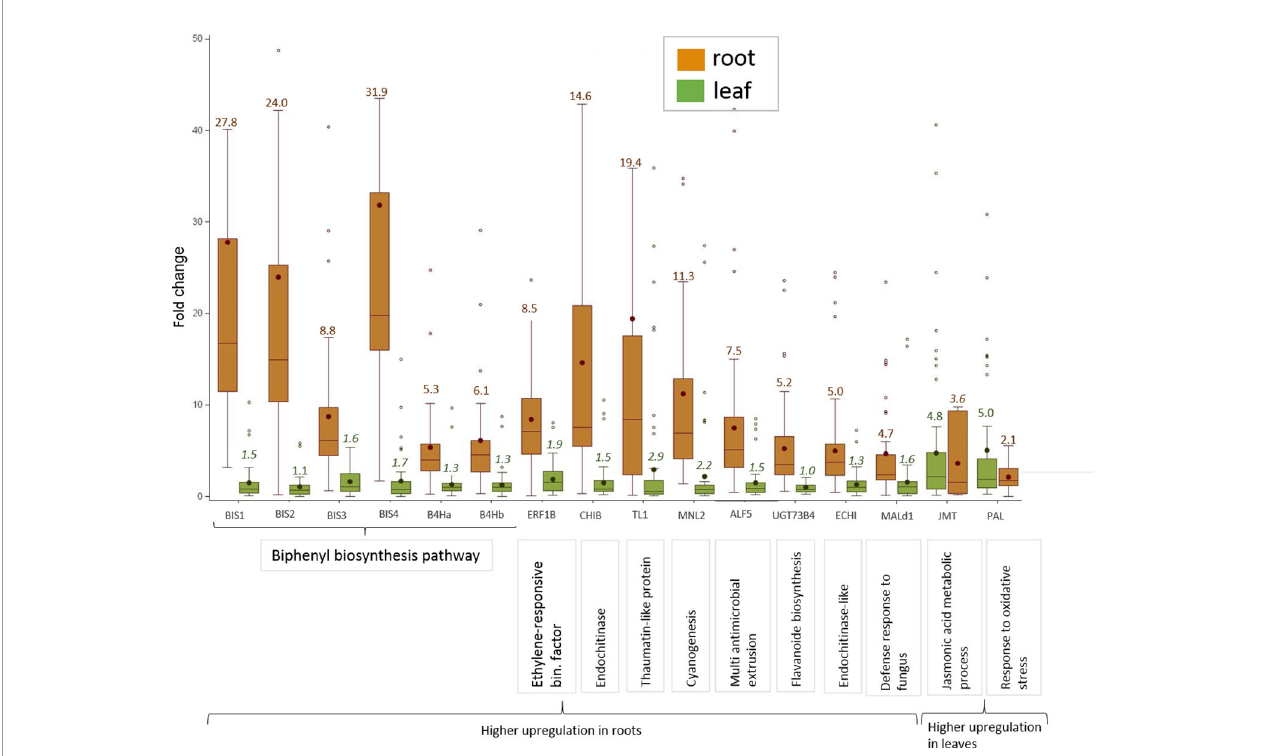
FIGURE 3 | Highly upregulated CGs in apple grown in ARD soils with an average DD Cq-fold change value > 4.5 in either root or leaf tissue after cultivation in ARD soil and their assignment to molecular function. The fold change values (ARD soils/ g ARD soils) are average values for the four genotypes, including fi ve (M26, B63 and MAL0595) or two replicates ( “ M9 ” ), respectively and the two soils (Meckenheim and Heidgraben). Non-signi fi cant fold change values are indicated in italics. The whiskers were not drawn to the minimum or maximum values, if they were longer than 1.5 times the interquartile range (IQR). Data points outside of this range of 1.5 × IQR were indicated as outliers (dots).